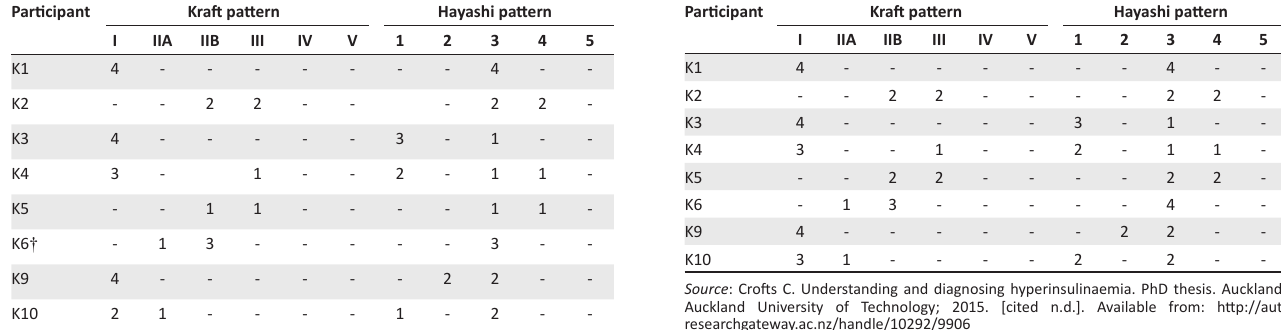
TABLE 3: Observed Kraft and Hayashi pattern frequencies on eight participants over four visits per participant. Participant Kraft